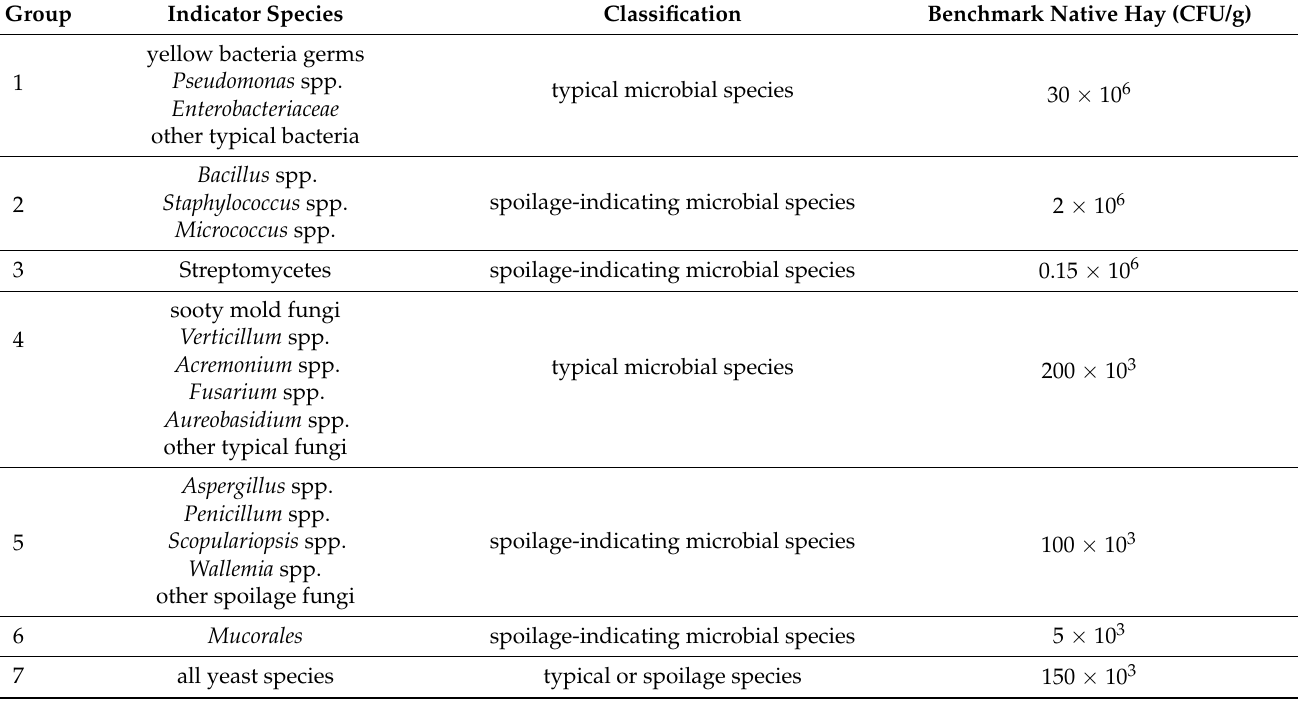
Table 1. Classification of the microbial species to indicator groups